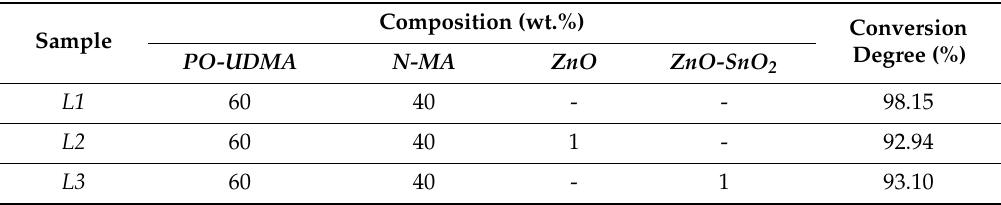
Table 1. Data for L1 , L2, and L3 formulations.